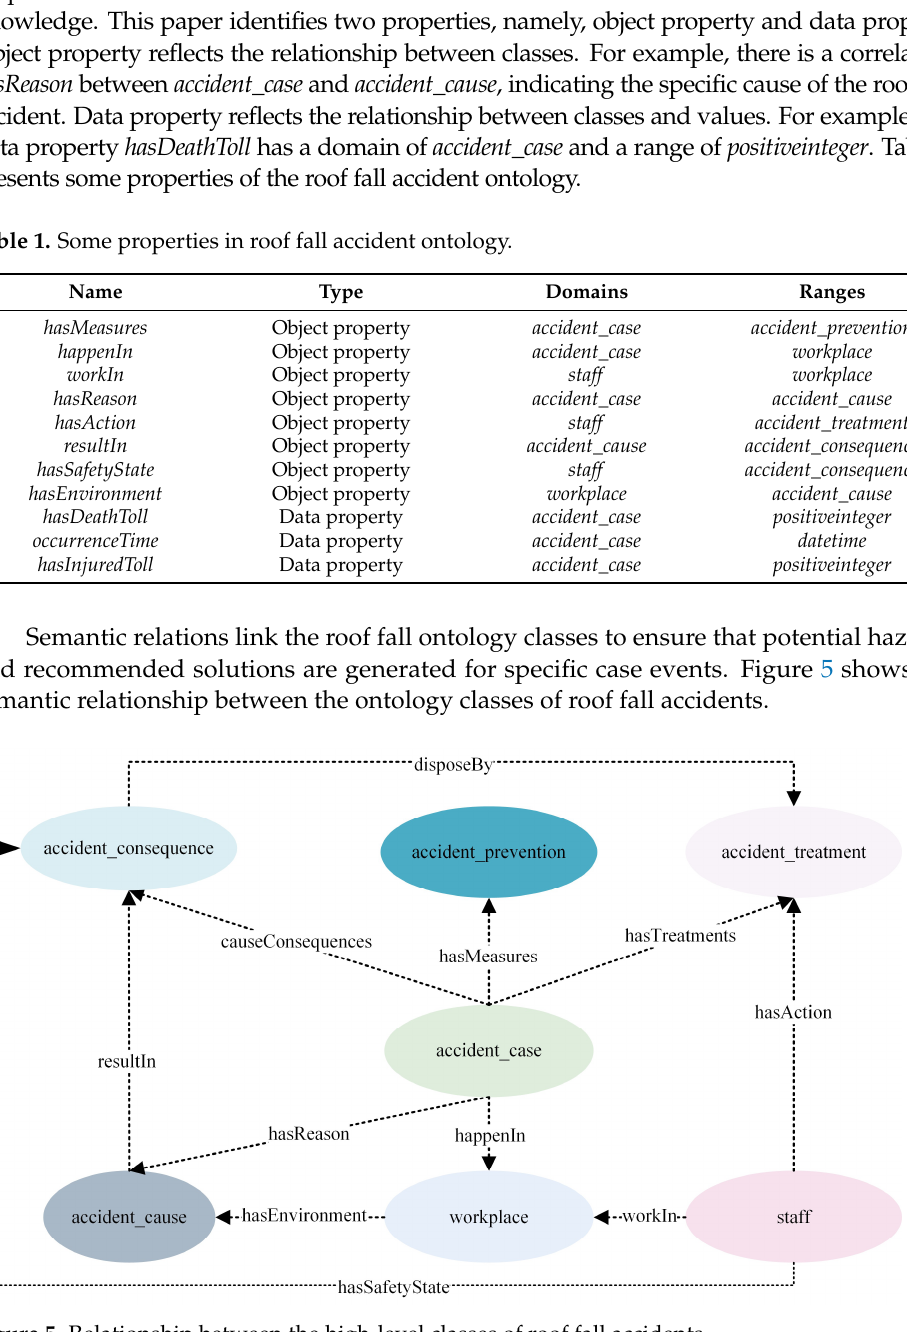
Figure 5. Relationship between the high-level classes of roof fall accidents.